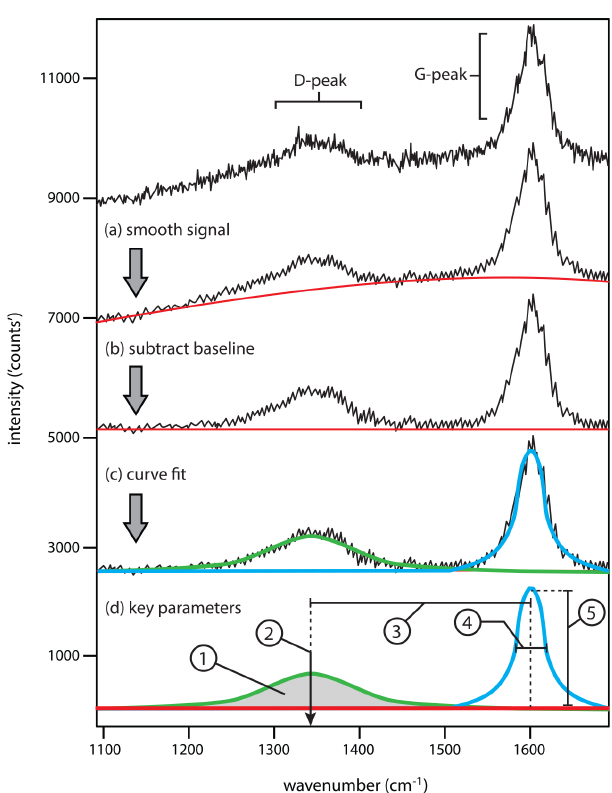
Figure 3. Deconvolution process using WiRE 3.4, showing (a) noise reduction, (b) baseline removal by means of user-guided cubic spline interpolation, (c) Gaussian curve fit of two curves, and (d) key components used in parameter calculations: (1) curve area ( A ), (2) peak position ( W ), (3) Raman band separation (RBS), (4) full width at half-maximum (FWHM), (5) peak intensity ( I